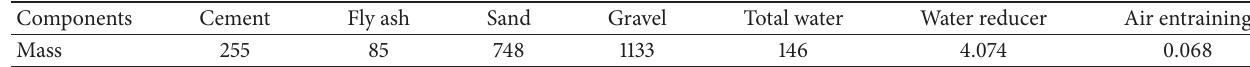
Table 2: Mixture proportions of concrete (kg/m 3 ).